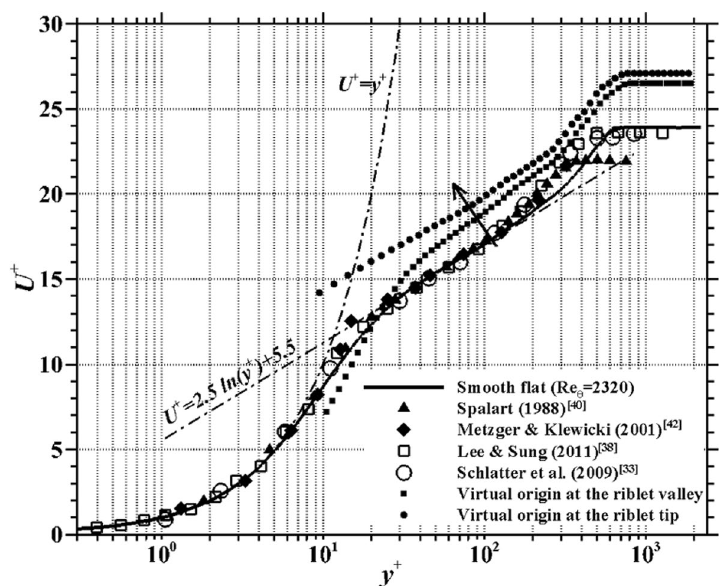
Fig. 9 Comparison of Van Driest transformed averaged velocity profiles in wall viscous units [33, 38, 40,